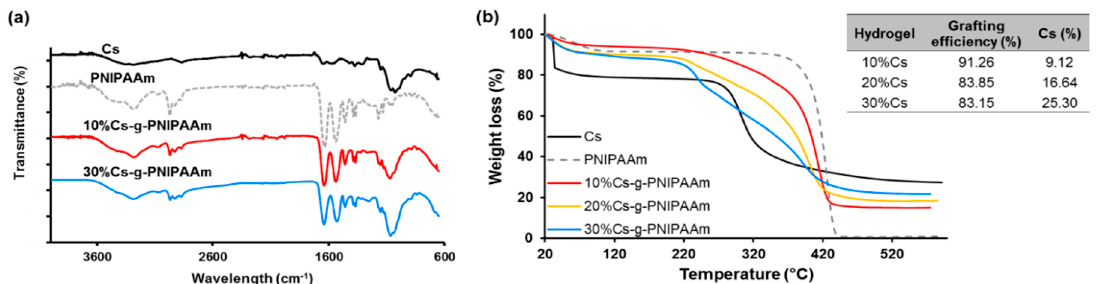
Figure 3. ( a ) FTIR confirming presence of the individual component in the copolymer, ( b ) grafting of the copolymers analyzed via TGA: Representative degradation profiles of hydrogel with varied Cs% showed two transition phases (typical of pure Cs and PNIPAAm). Mass remaining at 600 °C was attributed to Cs component and the mass % of Cs component from TGA corresponded to Cs utilized during hydrogel synthesis. Insert shows grafting efficiency and Cs context calculated with weight remaining at 600 °C.